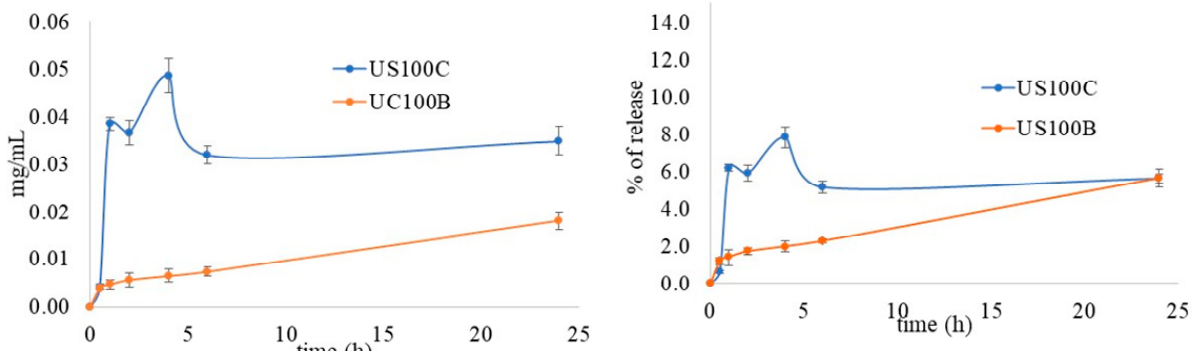
Figure 7. In vitro Ag + release profile from the composites, expressed as Ag + concentration ( left ) and % of release ( right ) as a function of time.